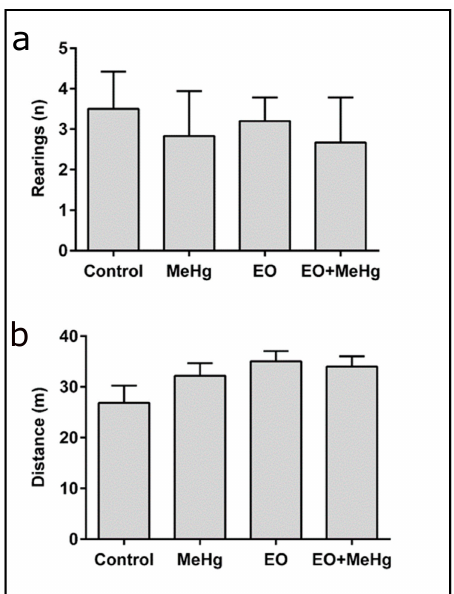
Figure 2. Spontaneous motor performance tested by open field test. No significant difference was observed in the number of rearings ( a ) and the total distance performed ( b ) by mice treated with clarified Euterpe oleracea juice (EO) once a day for 8 days and/or methylmercury (MeHg) for 4 days. Data are presented as mean ± SEM ( n = 8–10).